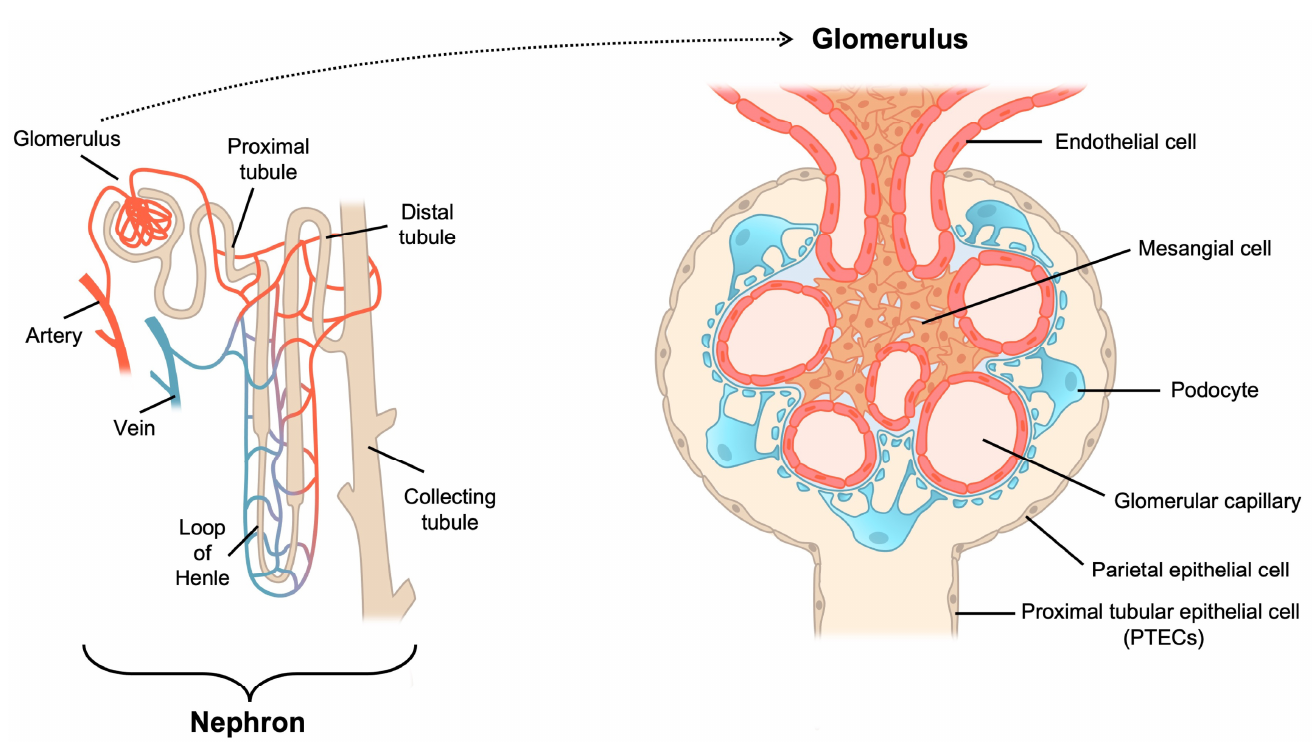
Figure 1. Nephron structure in the kidney. The nephron is the functional unit of the kidney. The glomerulus is the filtering unit located at the beginning of a nephron. Glomerular cells comprise endothelial cells, mesangial cells, podocytes and epithelial cells. Oxidative stress likely causes dysfunction of these cells, leading to renal